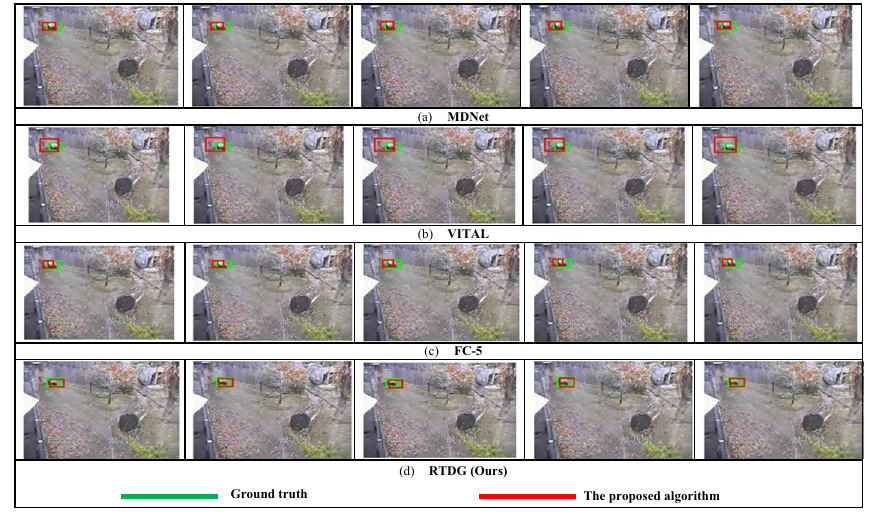
Fig. 10 Tracking results of the compared trackers on the ’Panda’ video (frames: 739 to